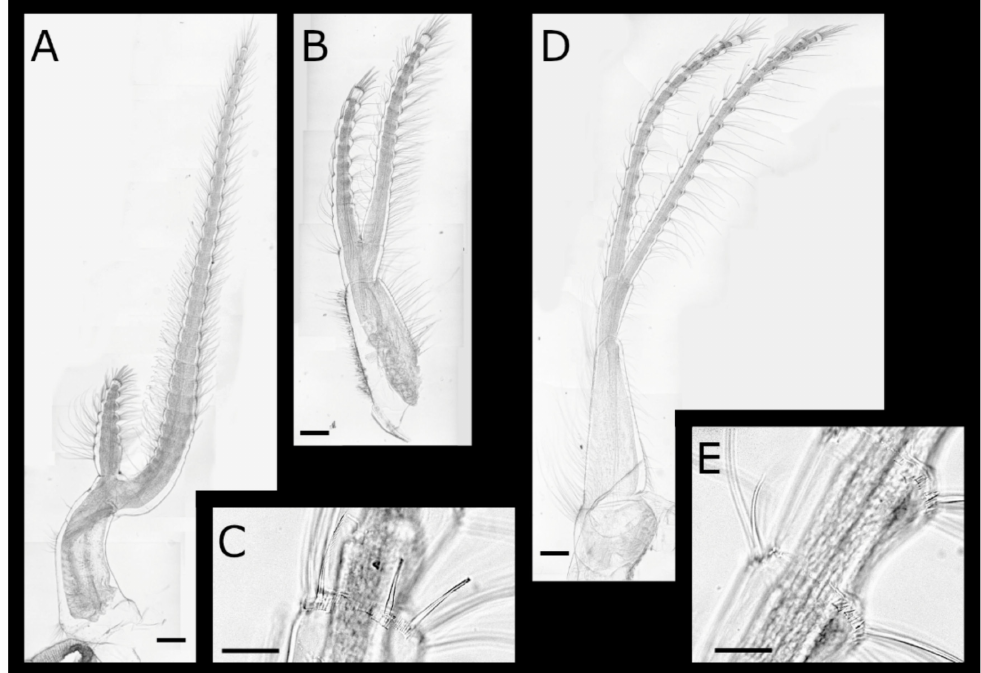
Figure 15. Euacasta excoriatrix sp. nov. Cirri I–III (WAM C71800, holotype). ( A ) left cirrus I; ( B ) left cirrus II; ( C ) ctenoid scales on cirrus II anterior ramus segment; ( D ) left cirrus III; ( E ) small erect spines on the anterodistal angle of cirrus III anterior ramus. Scale bars: A–B, D = 200 µ m; C, E = 50 µ